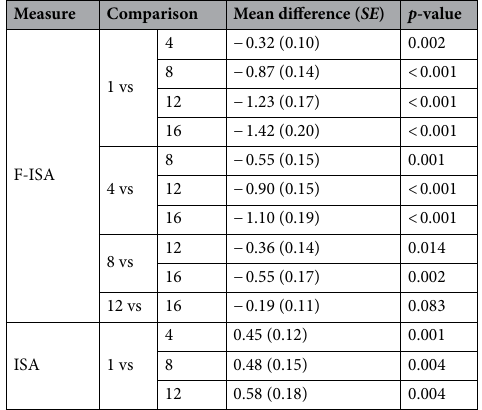
Table 2. Paired t-tests for F-ISA and ISA, significant comparisons only (F-ISA one-tailed, ISA two-tailed). Alpha levels are Bonferroni-Holm corrected.